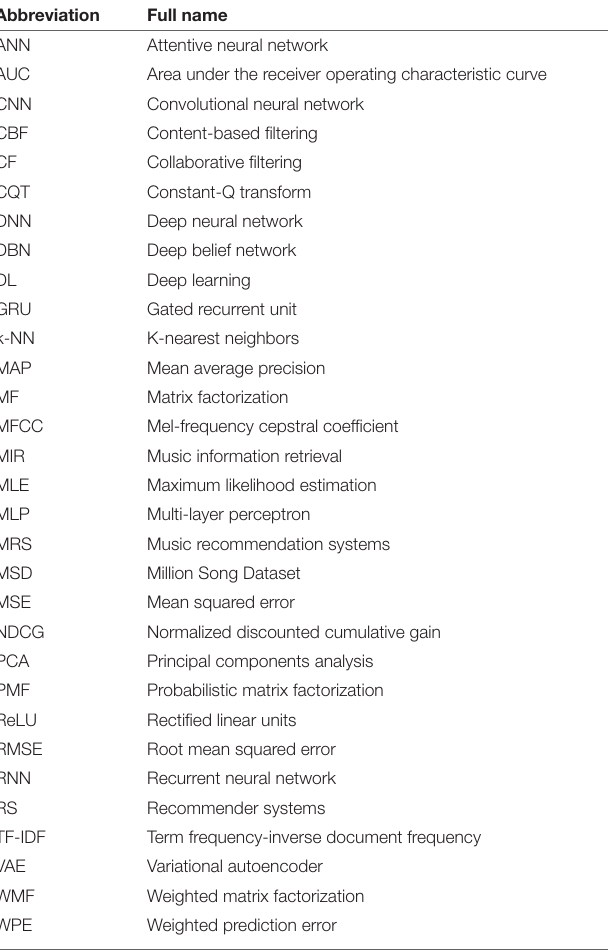
TABLE 3 | Abbreviations commonly used in this article and related literature.